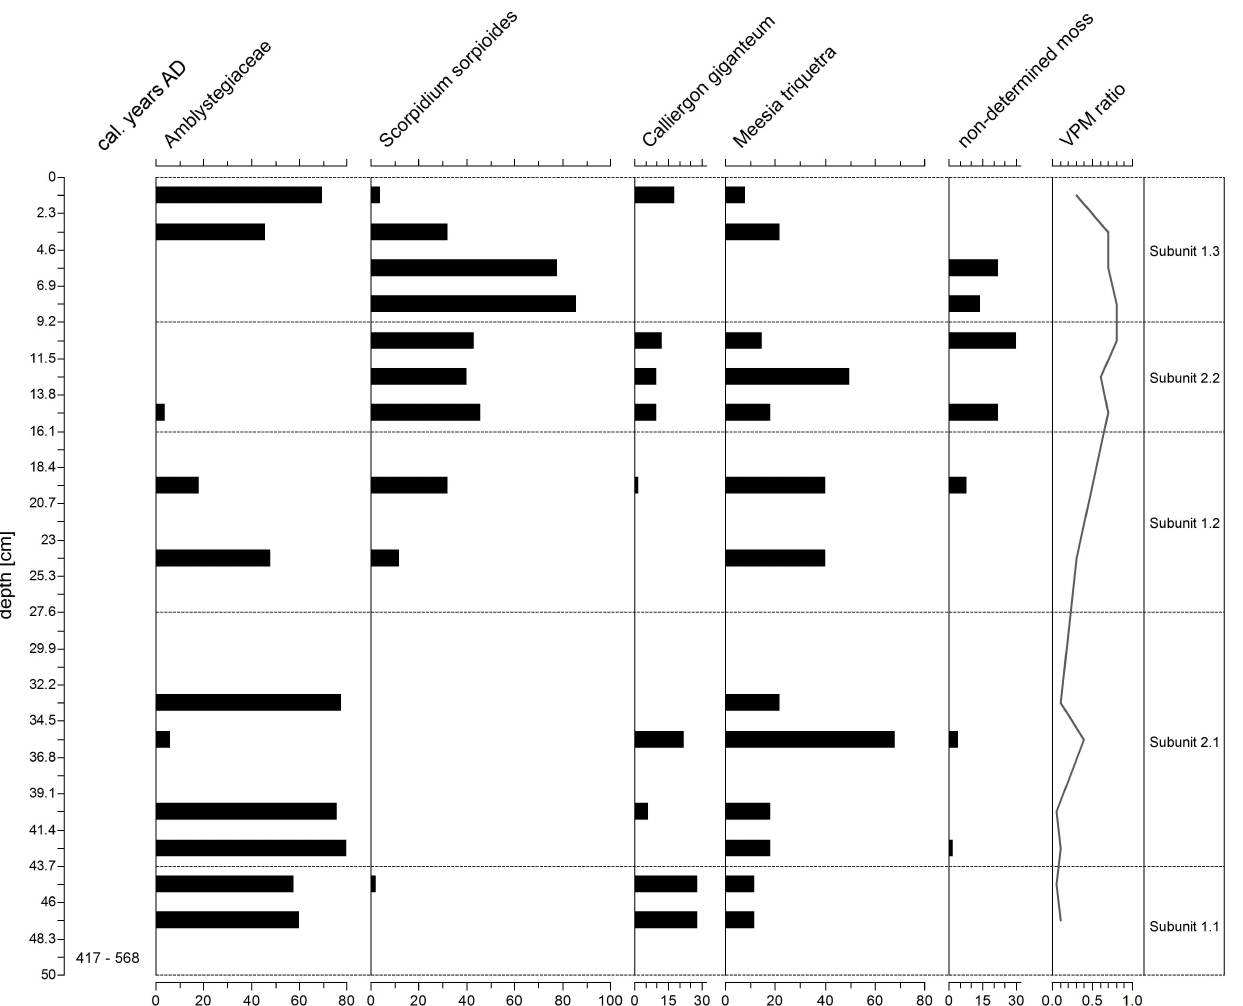
Fig. A4. Moss spectrum for Section B. The figure does not include the complete moss spectrum as only several Amblystegiaceae taxa were analysed in this section, especially Scorpidium scorpioides, Calliergon giganteum , and Meesia triquetra (after Schilling,